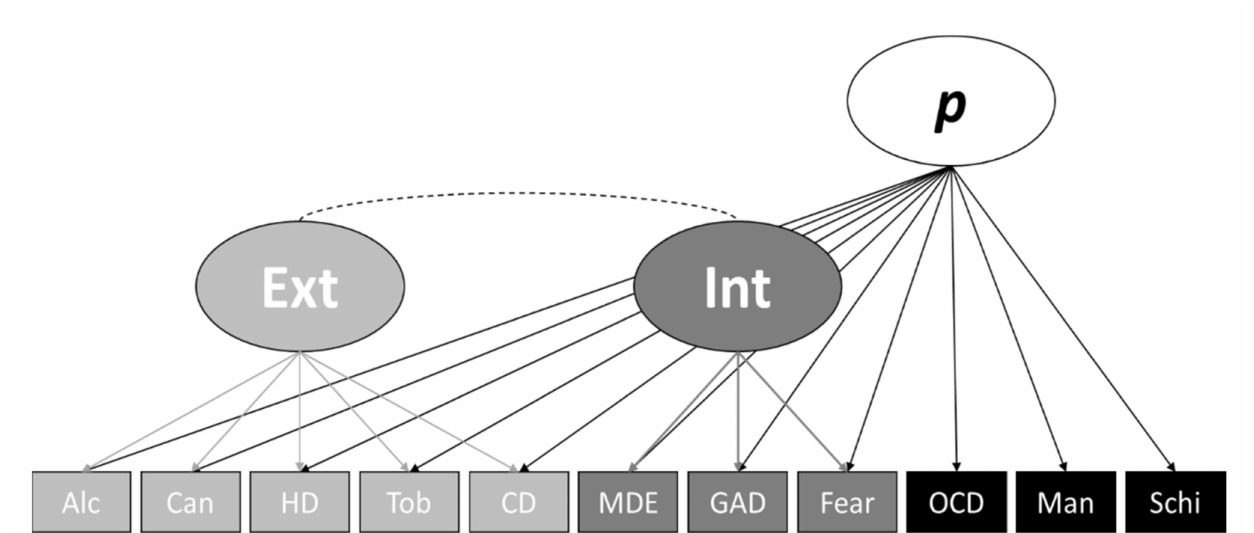
Figure 1. Simulated Data Structural Model. Note . Alc = alcohol; Can = cannabis; HD = hard drugs; Tob = tobacco; CD = conduct disorder; MDE = major depressive episode; GAD = generalized anxiety disorder; Fear = fears and phobias; OCD = obsessive-compulsive disorder; Man = mania; Schi = schizophrenia; Ext = externalizing; Int =